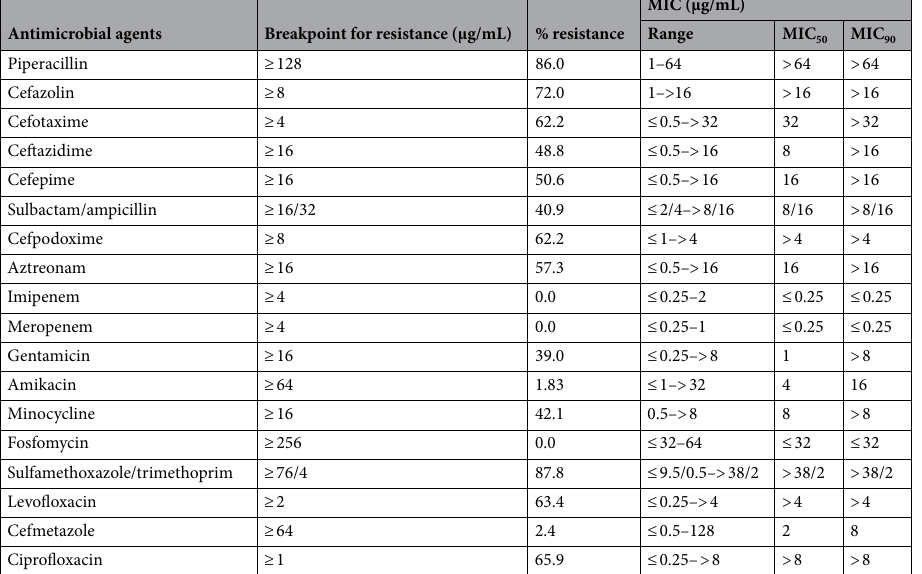
Table 1. Minimum inhibitory concentration 50 (MIC 50 ) and Minimum inhibitory concentration 90 (MIC 90 ) values and antibiotics resistance percentage values of 164 E. coli